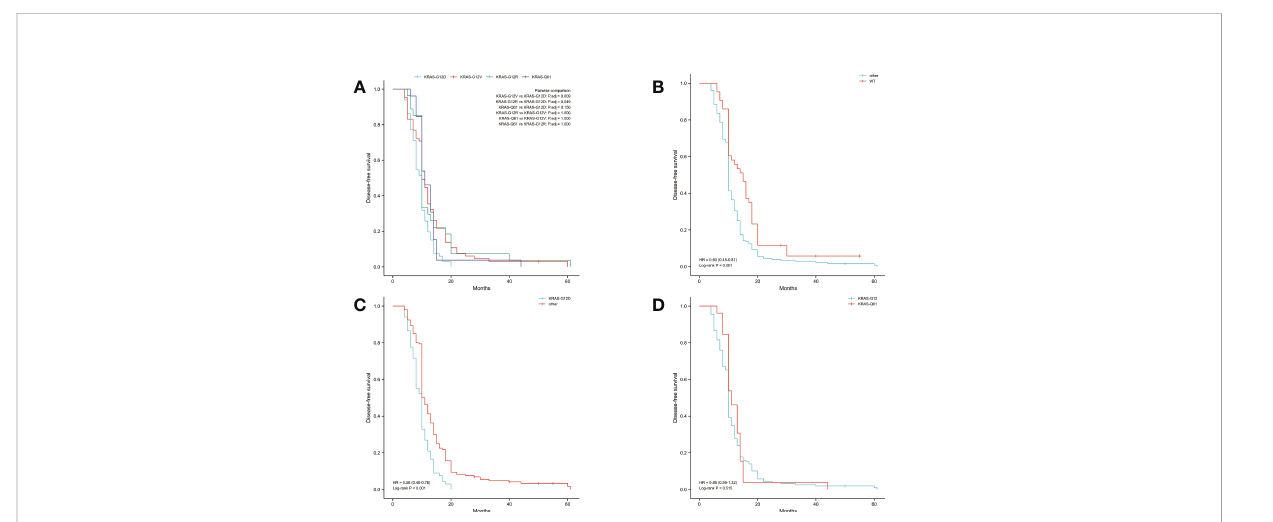
FIGURE 3 Disease-free survival (DFS) in all patients was examined with Kaplan-Meier plots and log-rank tests. (A) Comparison of four groups (KRAS-G12D, KRAS-G12V, KRAS-G12R, KRAS-Q61) with KRAS mutations. (B) Evaluation of KRAS mutation carriers against individuals with the wild-type gene. Additional subsets were denoted by the names KRAS-G12D, KRAS-G12V, KRAS-G12R, and KRAS-Q61. (C) Those with the KRAS-G12D mutation were compared to those without it and vice versa. Wild-type KRAS, KRAS-G12V, KRAS-G12R, and KRAS-Q61 were the other subsets. (D) A comparison of the mutations at codons 12 and 61. The KRAS-G12D, V, and R codon 12 groups were present. The KRAS-Q61H, Q61R, Q61K, and Q61L codons were part of the codon 61 group. WT, KRAS wild-type; HR, hazard ratio; The numbers in parentheses represent 95% con fi dence intervals.